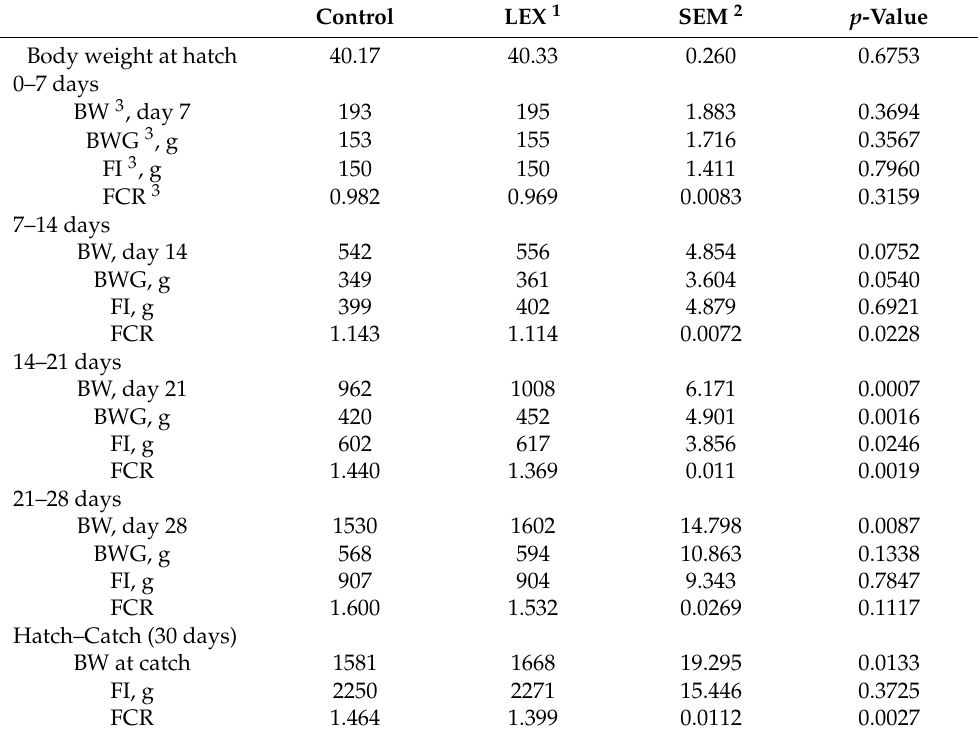
Table 2. Effect of the dietary supplementation of LEX to low-energy diets on the growth performance of broilers in each experimental group measured at different growth